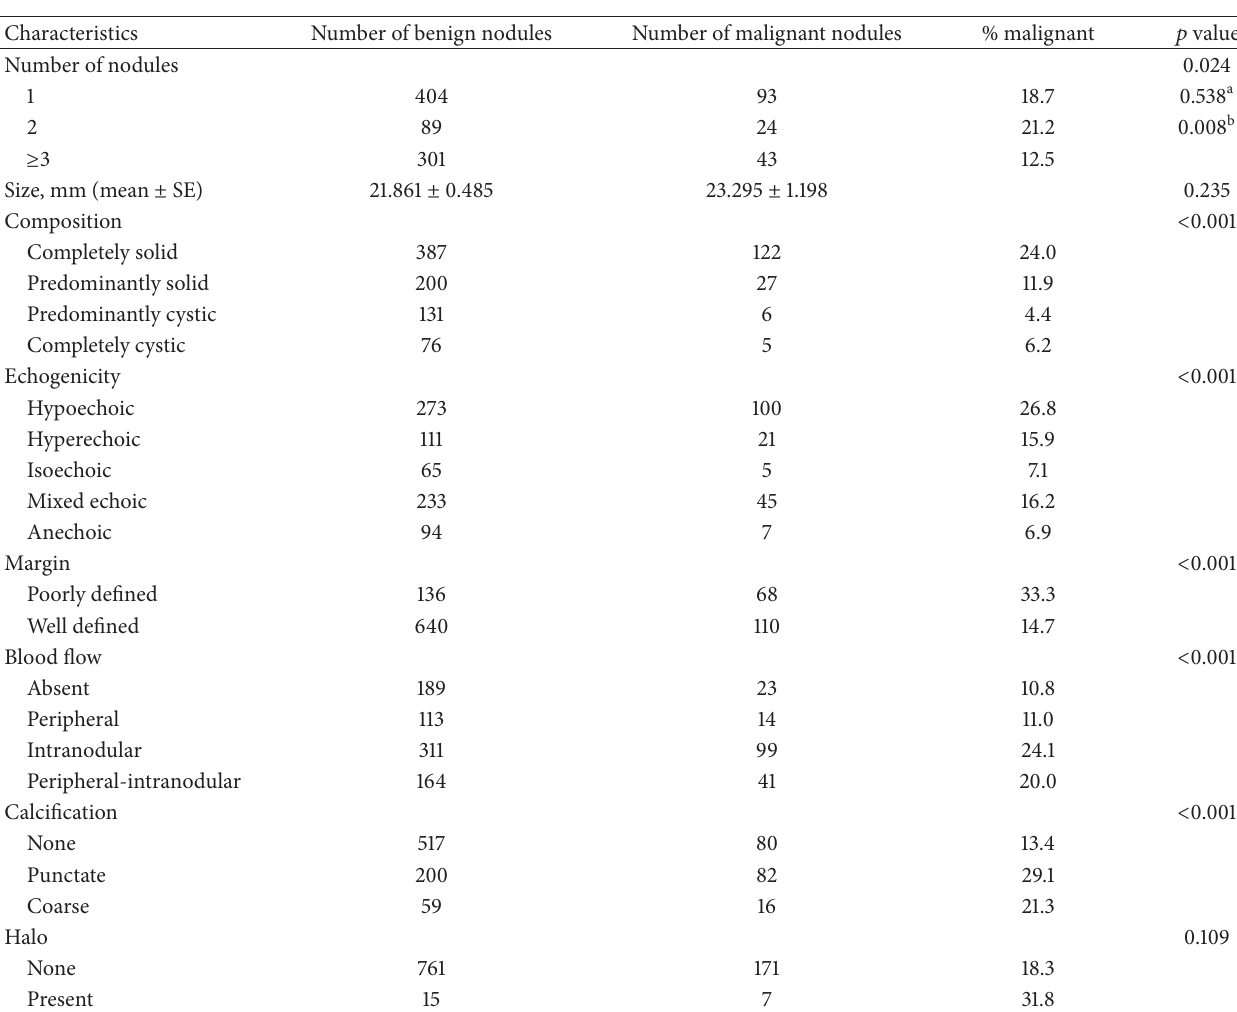
Table 5: Ultrasonographic characteristics of thyroid